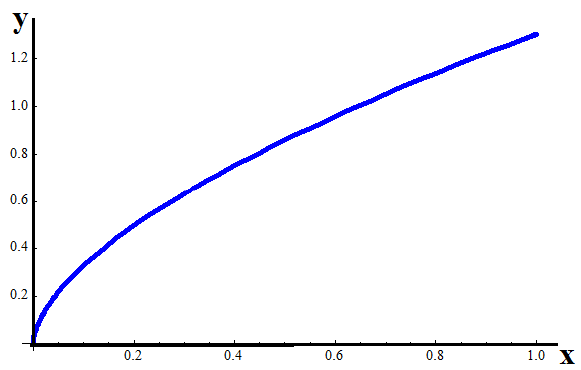
Figure 4. The non-dimensional axial displacement of the fractional bar with γ = 0.63. Further, for the Λ -fractional deformation for dimension γ = 0.8, the displacement function is shown in Figure 5.